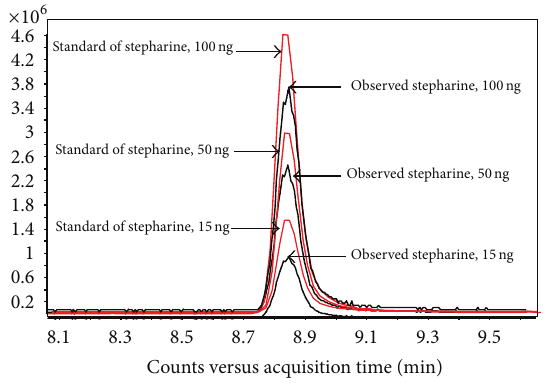
Figure3:Comparisonofpeakareasofthespikedstandardsolutions ofstepharineinamounts15,50,and100 ng(solidlines)andobserved amount of stepharine after extraction from rabbit plasma (dashed lines). The chromatograms demonstrate peaks of the most abundant fragment ion with 𝑚/𝑧 = 161.2 .